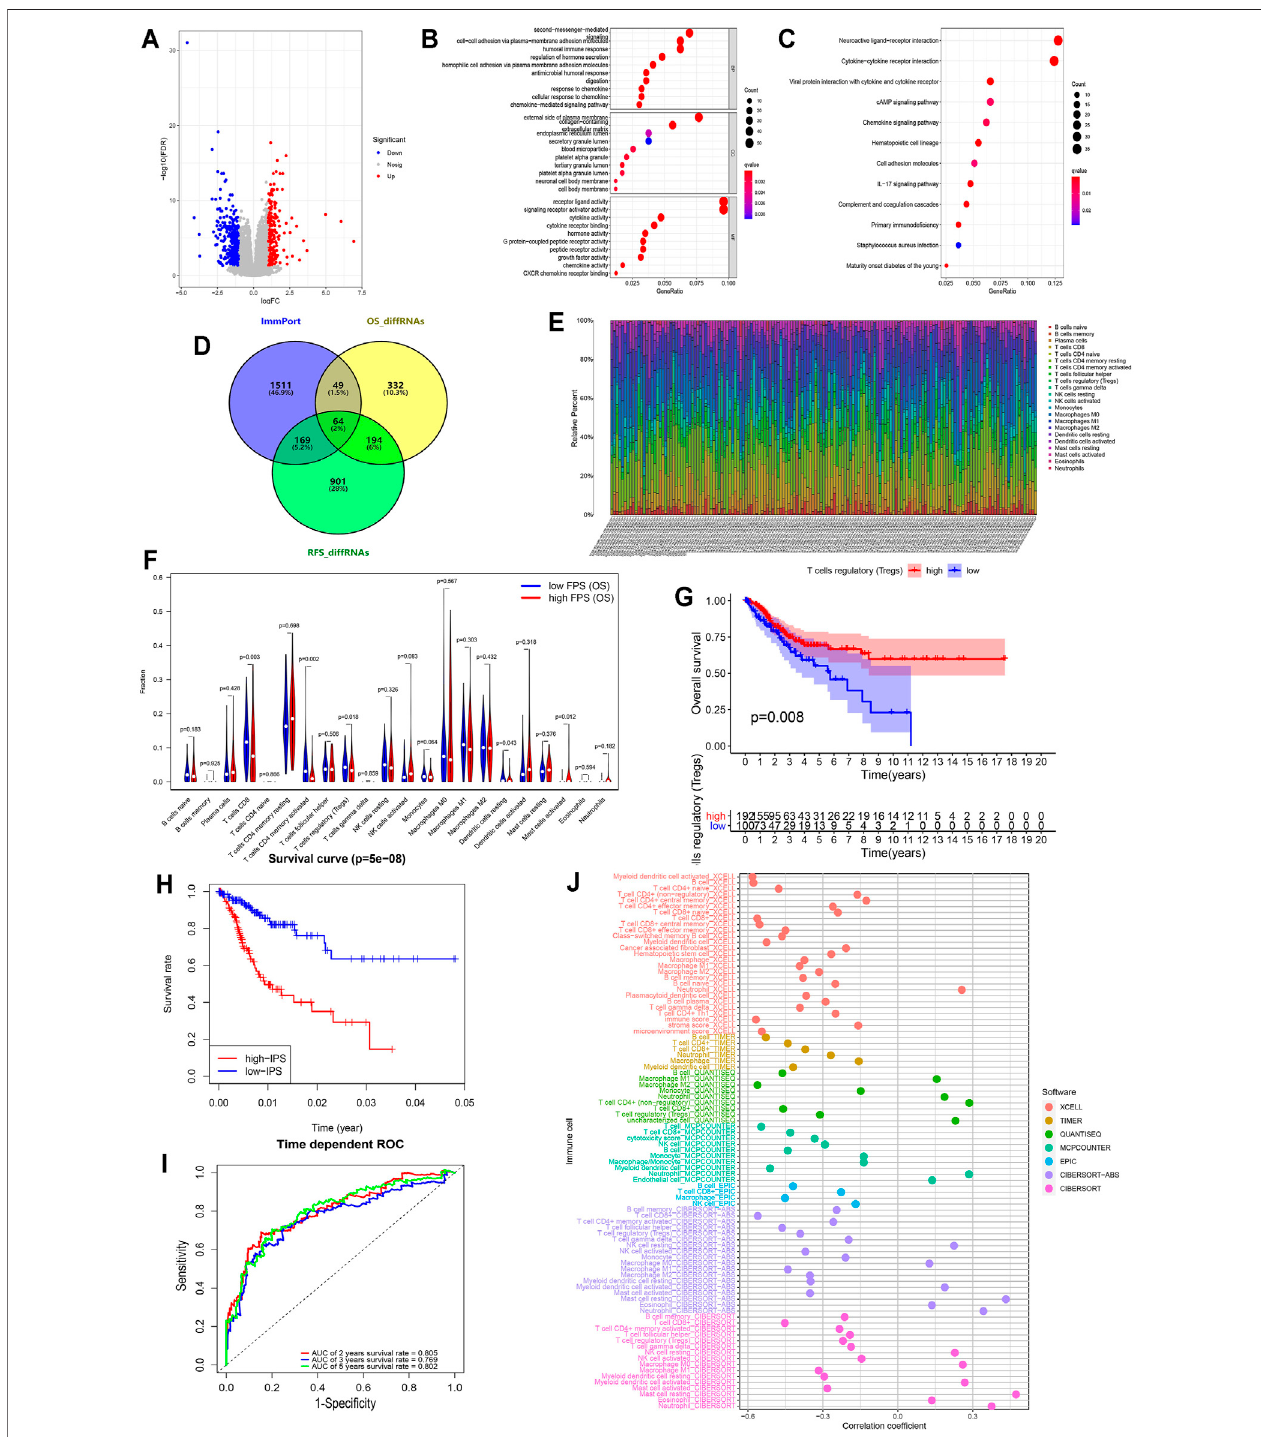
FIGURE 3 | Immune in fi ltration in CESC among the two risk FPS groups and construction immune signature IPS based on FARGs. (A) Volcano plot of DEGs in high-FPS ( n (cid:1) 146) compared to low-FPS (n (cid:1) 146) groups, |log 2 FC| > 1 and p -value < 0.05 served as the cutoff. (B,C) The GO terms (B) and KEGG pathways (C) enriched based on the DEGs. (D) Venn diagram showing 64 genes contained in the immune gene list from ImmPort Shared Data website, OS-related DEGs and RFS- relatedDEGs,while49OSuniqueDEGsand169RFSuniqueDEGswerealsodisplayed. (E) Thestackedcolumnchartexhibitedtheproportionof22immunecells in 309 patients. (F) Violin plot showed the abundance and comparison of different immune cells in different FPS groups. (G) Kaplan-Meier survival curves for patients withdifferentin fi ltratedTregs. (H) Kaplan-MeiersurvivalcurvesforpatientOSwithhighandlowIPSbasedonimmunesignature. (I) TheROCcurvesbasedonIPSfor2-, 3-, and 5-years OS probabilities. (J) The correlation analysis of IPS and immune pattern acquired by xcell, TIMER, quanTIseq, MCP-counter, EPIC, and CIBERSORT.